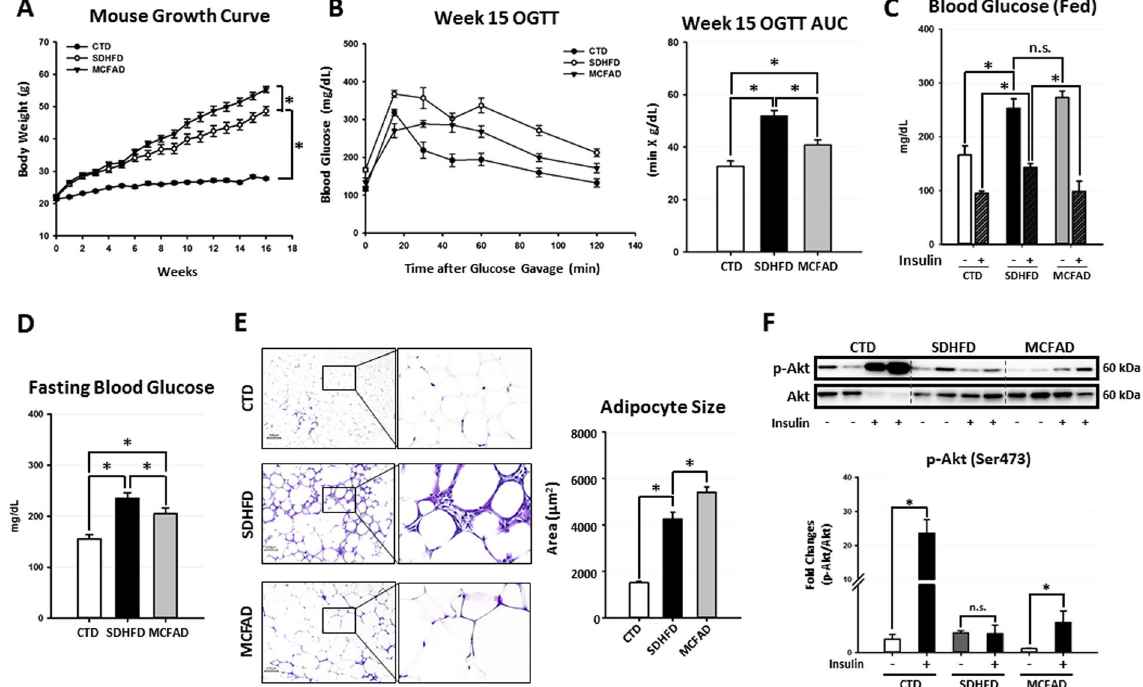
Figure 1. Increasing dietary MCFA ratio delayed Type 2 diabetes development in HFD-fed mice. Eight-week- old male C57BL/6 mice were fed with either the control low-fat diet (CTD), standard high-fat diet (SDHFD), or MCFAs-rich high-fat diet (MCFAD) for 16 weeks. During the experiment, mouse body weight was checked every week ( A ). Development of systemic insulin resistance and Type 2 diabetes was analyzed by conducting OGTT test at the 15 th week ( B ) and measuring fed blood glucose levels before and after I.P. insulin injection (0.5 IU/kg body weight, 30 min) ( C ), as well as starving blood glucose at the 16 th week ( D ). Adipocyte cell size in H&E-stained sections was quantified automatically using Adiposoft software ( E ). For adipose insulin resistance, the phospho-Akt (Ser473) levels of adipose tissues from mice injected with or without I.P. insulin (0.5 IU/kg body weight, 30 min) were analyzed. Representative immunoblots and densitometric quantification of phospho- Akt (Ser473) are presented ( F ). Values are mean ± SEM. (n = 6). * Indicates statistical significance, P < 0.05. n.s.: no significant difference. Full-length blots are presented in Supplementary Figure